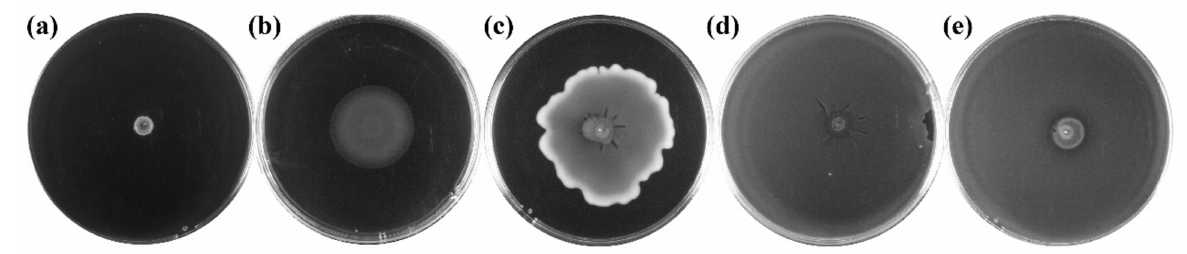
Figure 2. Motility panel of Clostridium strains isolated from pit mud: ( a ) non-motile; ( b – e )